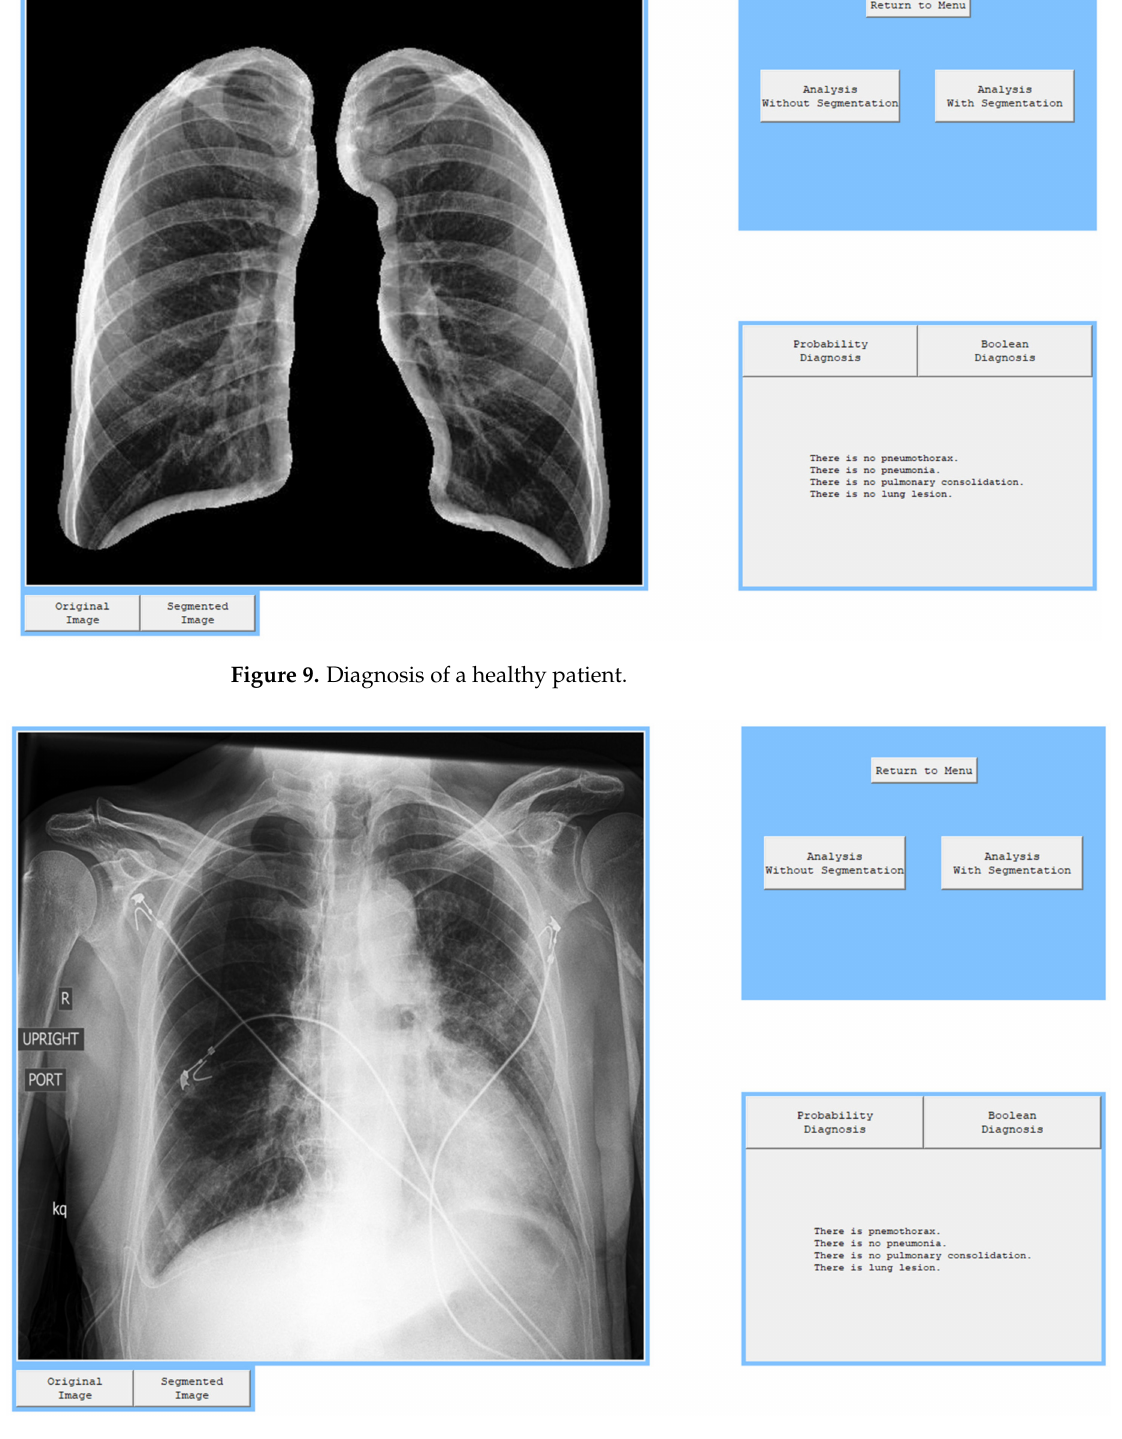
Figure 10. Diagnosis of patient with pneumothorax and lung